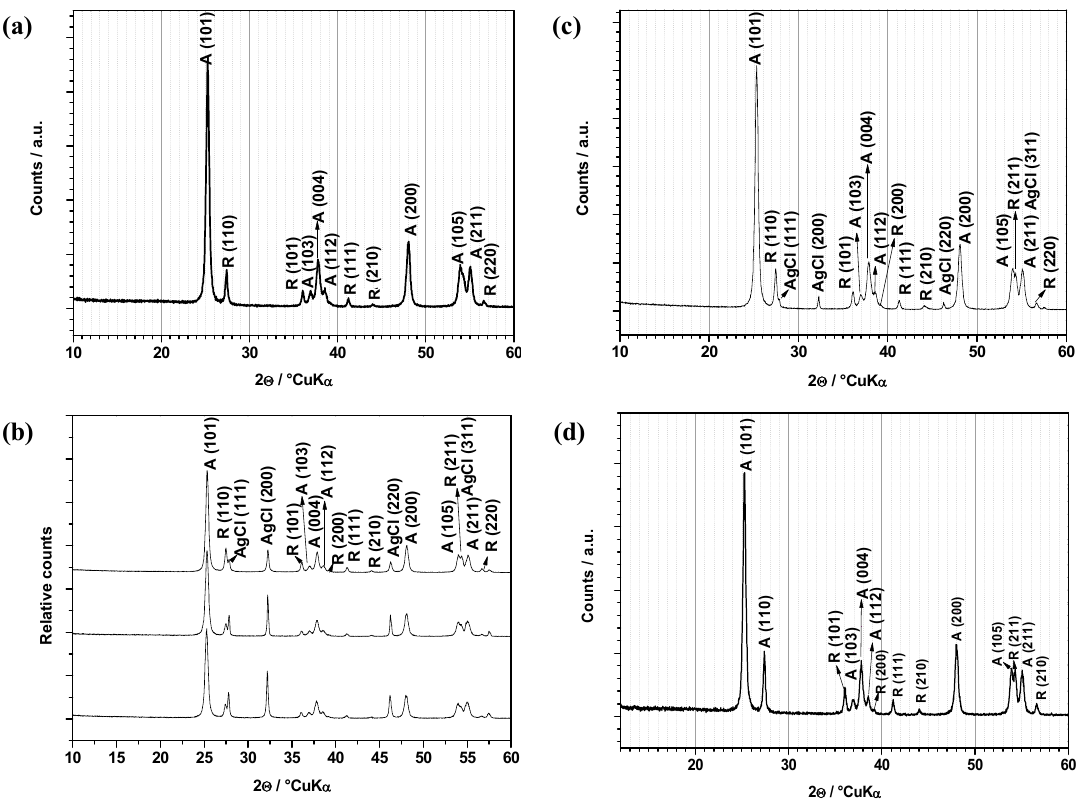
Figure 1. X ‐ ray diffraction (XRD) powder patterns of prepared Ag modified TiO 2 photocatalysts compared to original TiO 2 P25 ( a ): S1a–c from bottom to top ( b ), S2 ( c ), and S3 ( d ).